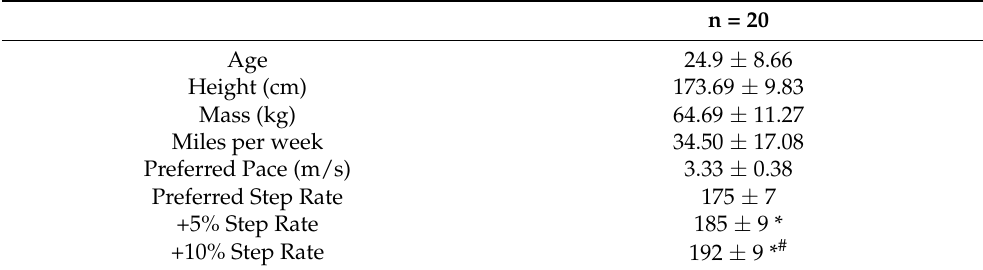
Table 1. Subject characteristics, preferred running pace, and step rates